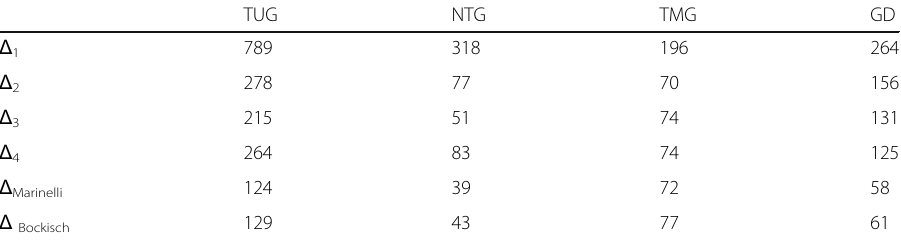
Table 4 Root mean squared deviations Δ i of D ha from D t (MBq) for approaches 1 – 4 and activities derived from the EANM equations SOP 8 and 9 of Marinelli and Bockisch, respectively TUG NTG